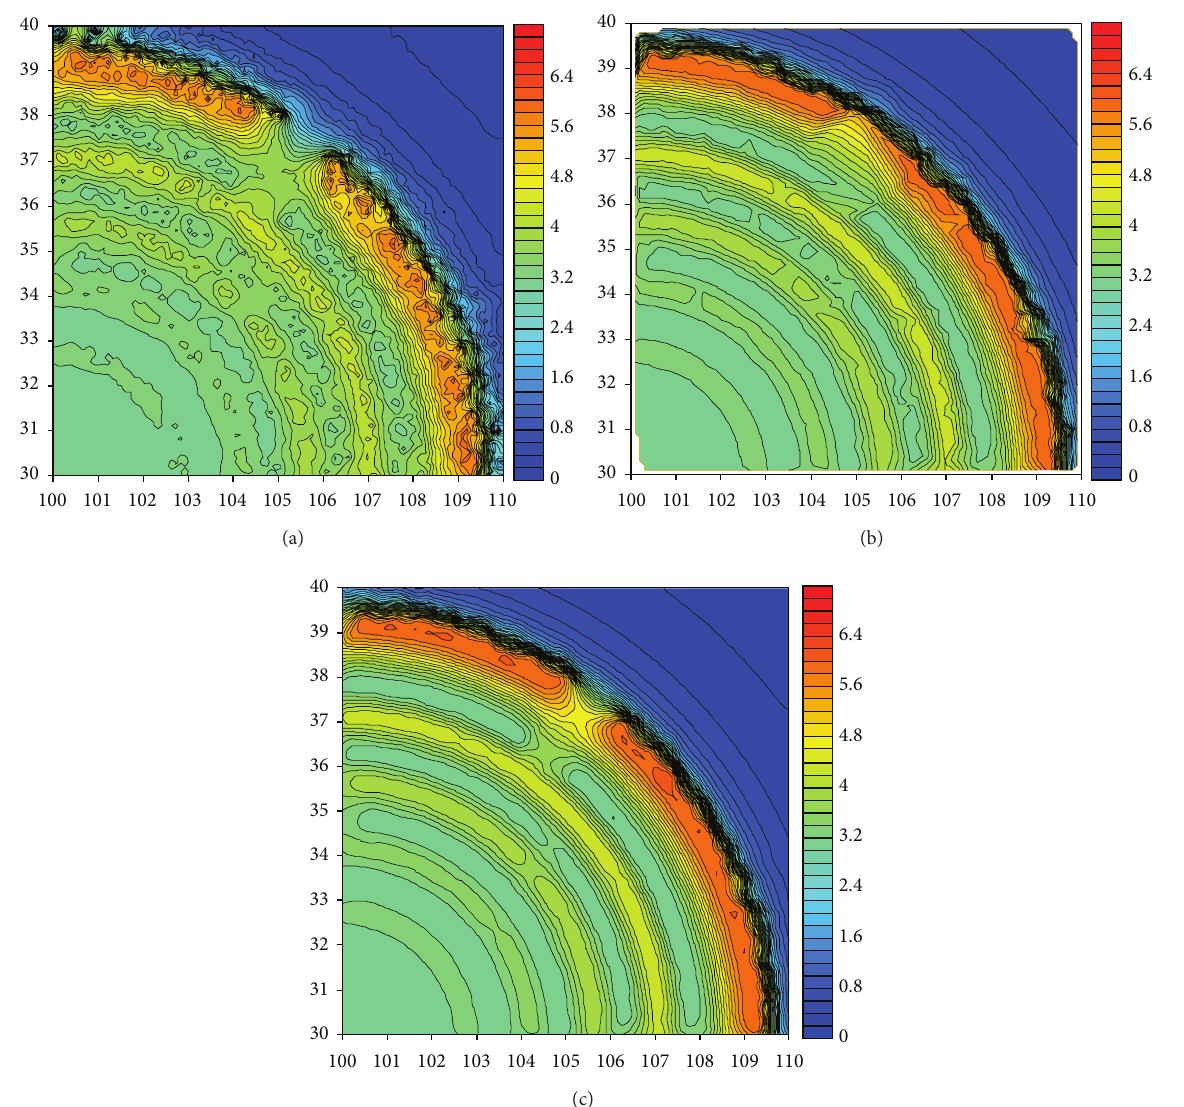
Figure 6: Analyzed temperature results (unit: ∘ C) from classical geostatistical tools such as (a) inverse distance to a power, (b) triangulation with linear interpolation, and (c) Kriging